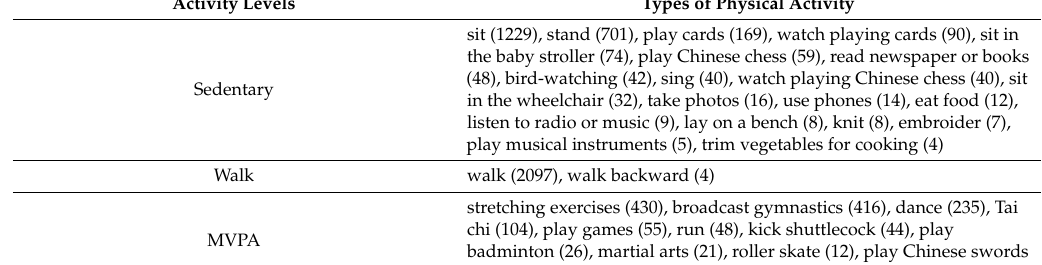
Table 4. Physical activities occurring in the neighborhood parks (numbers of people observed).